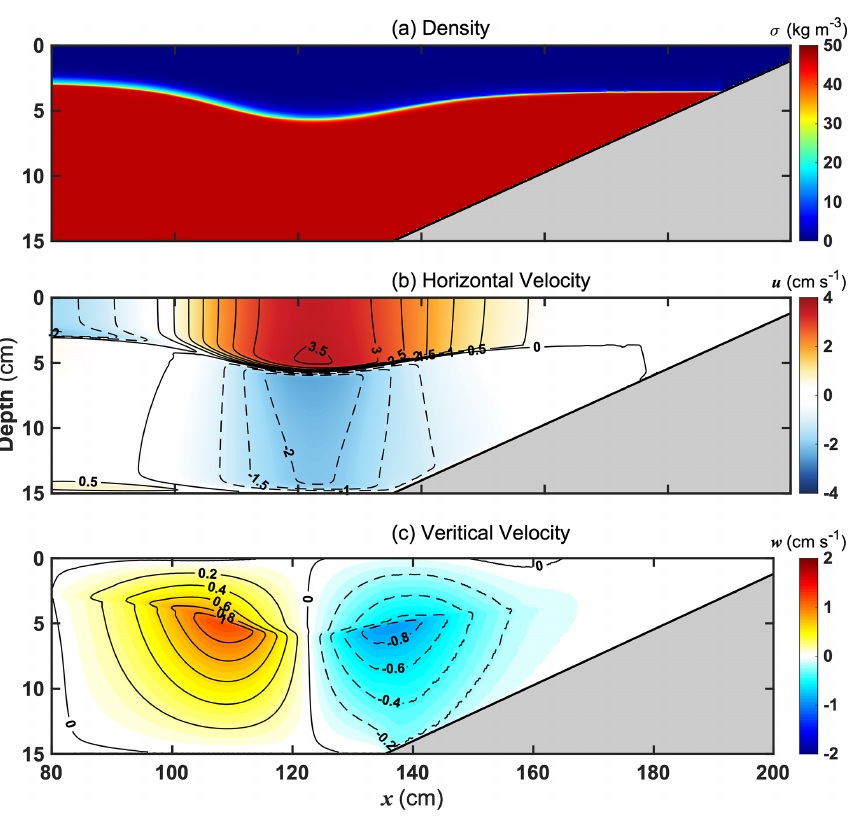
Figure 14. As in Fig. 6, but with the time referring to t = 15s before the wave shoaling.